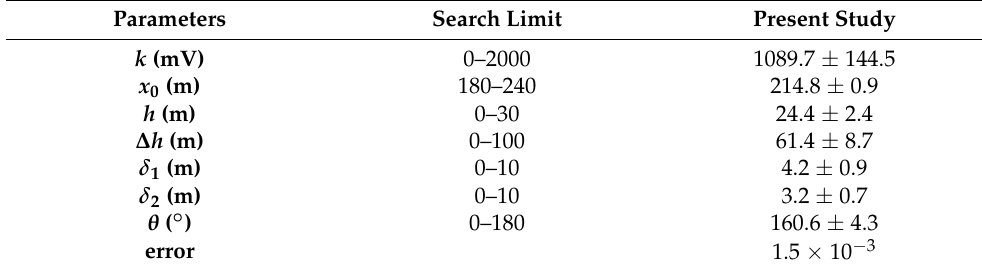
Table 5. Interpretation of Filizchai polymetallic deposit, Southern Greater Caucasus, Azerbaijan.